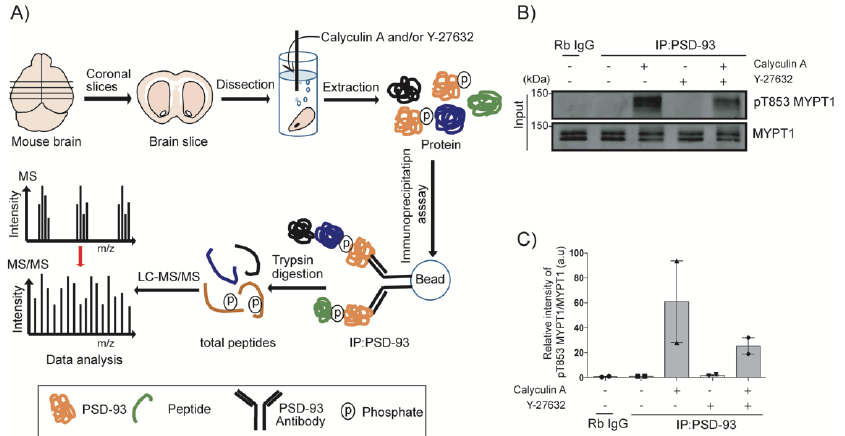
Figure 4. Identification of PSD-93-binding proteins by LC-MS/MS. ( A ) Schematic presentation of the LC-MS/MS method using striatal slices. Coronal striatal slices were taken from mice brain with vibratome and treated with calyculin A (250 nM) for 60 min and/or Y-27632 (20 µM) for 60 min—and then subjected to immunoprecipitation using an anti-PSD-93 antibody. The Trypsin/Lys-C was used to digest immunoprecipitated proteins, which were then subjected to LC-MS/MS to identify PSD-93 interacting proteins. ( B ) The input lysate from striatal slices was analyzed by immunoblot analysis with anti-pT853 MYPT1 and anti-MYPT1 antibodies. ( C ) The bar diagrams show the quantitative analysis results of Table 1. Phosphorylation-dependent positively regulated PSD-93 binding partners. LC-MS/MS data were sorted according to two criteria: 1. the sample-control vs. IgG-control ratio was 10:1; and 2. binding with PSD-93 was greater upon calyculin A stimulation than under the sample-control condition or Y-27632 stimulation. The list shows the proteins that were positively regulated upon the phosphorylation of PSD-93 by Rho-kinase.